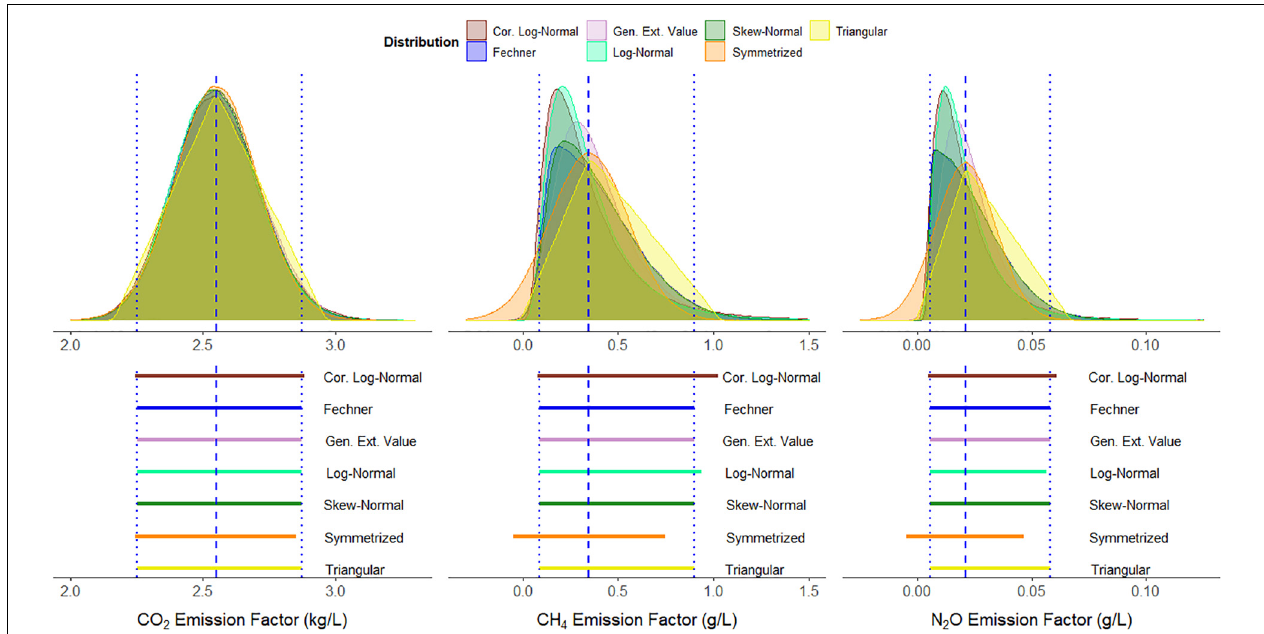
FIGURE 2 | Comparison of various distributions fitted to the emission factors for CO 2 , CH 4 , and N 2 O in lubricant (for commercial, institutional, residential, agricultural and land transportation use) and their corresponding intervals covering 95 % of the simulated population for each distribution. The left column of figures corresponds to results for CO 2 emission factor, with the fitted distributions on the upper side and 95 % intervals on the lower side. The middle column of figures corresponds to CH 4 emission factor and the right column of figures to N 2 O emission factor, with fitted distributions on the upper side and 95 % intervals on the lower side. The dashed line corresponds to the best estimate reported f and the dotted lines to its asymmetric interval [ f − U L , f + U R ] covering an approximate probability of 95 % taken from the official database of Costa Rican emission factors (IMN,